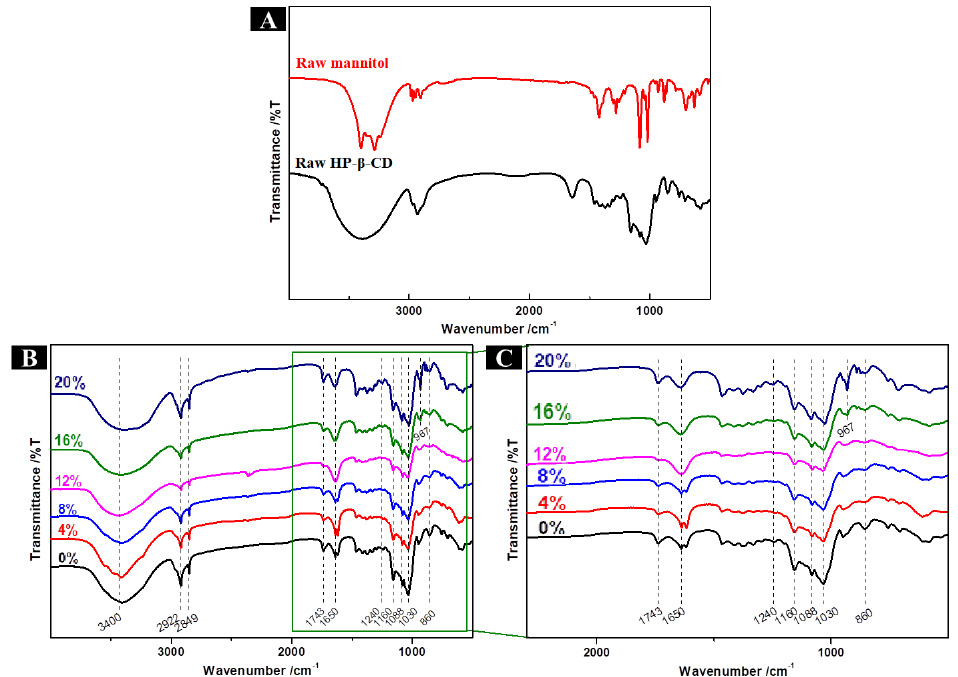
Figure 10. ( A ) FTIR spectra of microcapsule shell materials; ( B ) FTIR spectra and ( C ) enlarged partial FTIR spectra of HP- β -CD/MAN microcapsules with 0% – 20% MAN ratios.